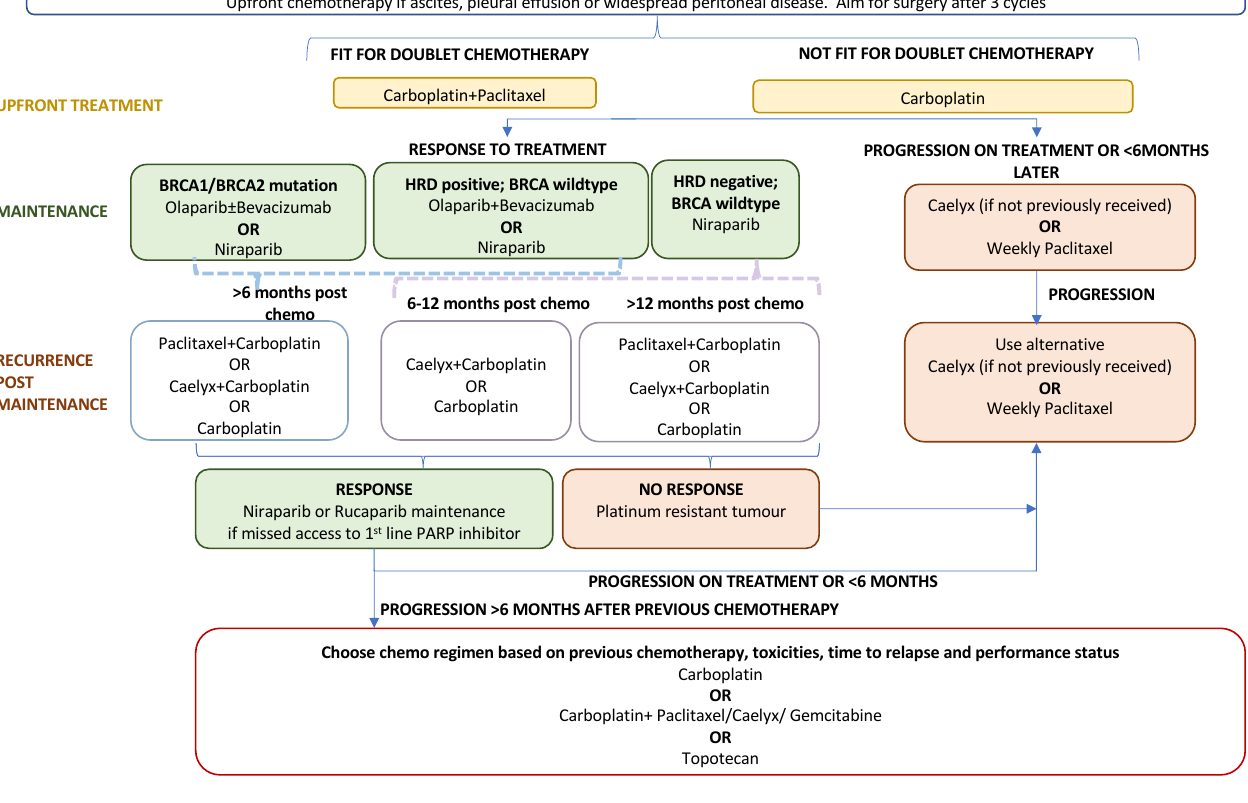
Figure 2. Treatment algorithm for advanced epithelial ovarian cancer.